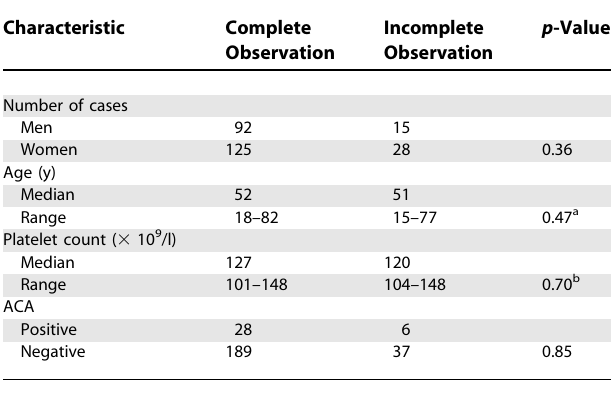
Table 1. Comparisons of Clinical Characteristics between Individuals Who Completed the Observation Phase and Those Who Withdrew from Study before 6 mo Characteristic